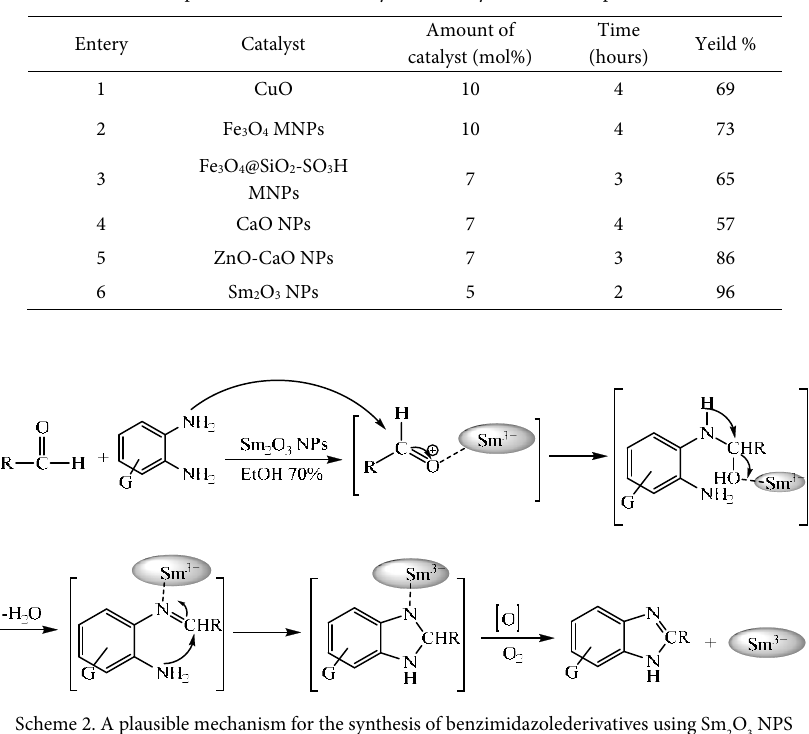
Table 6. A comparison of different catalysts for the synthesis of compound 5 in EtOH